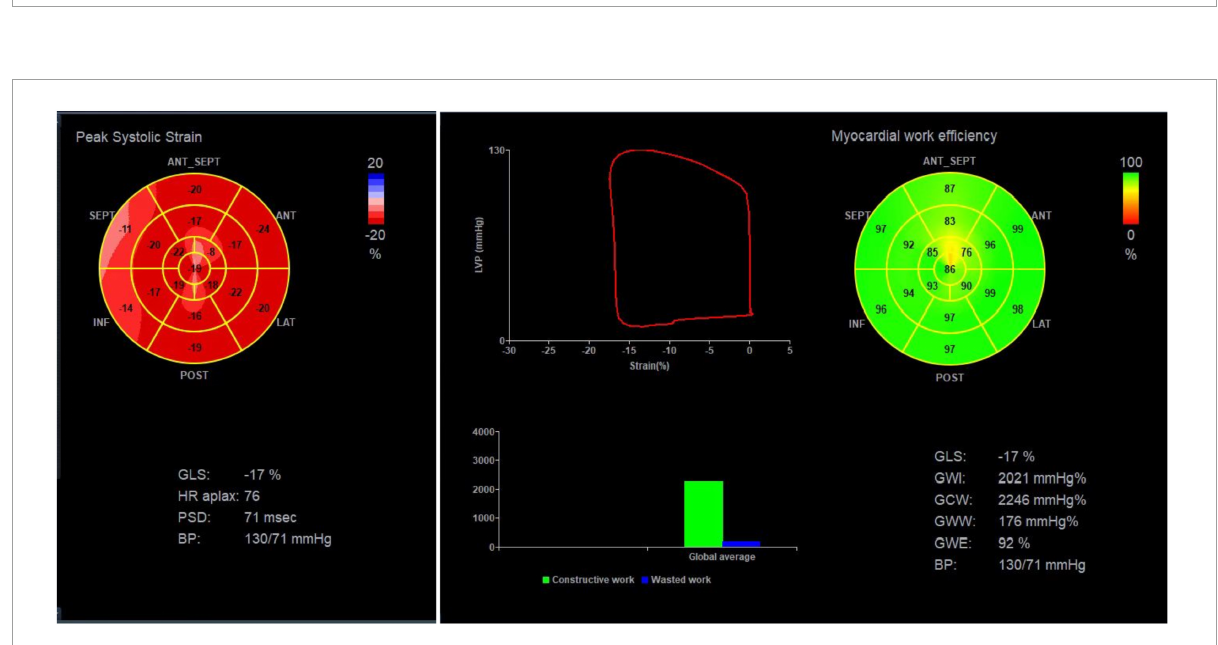
FIGURE2 Collection of myocardial work parameters from the EchoPAC workstation. Illustration of the 17-segment strain time curve and calculation of GLS, GWI, GCW, GWW, and